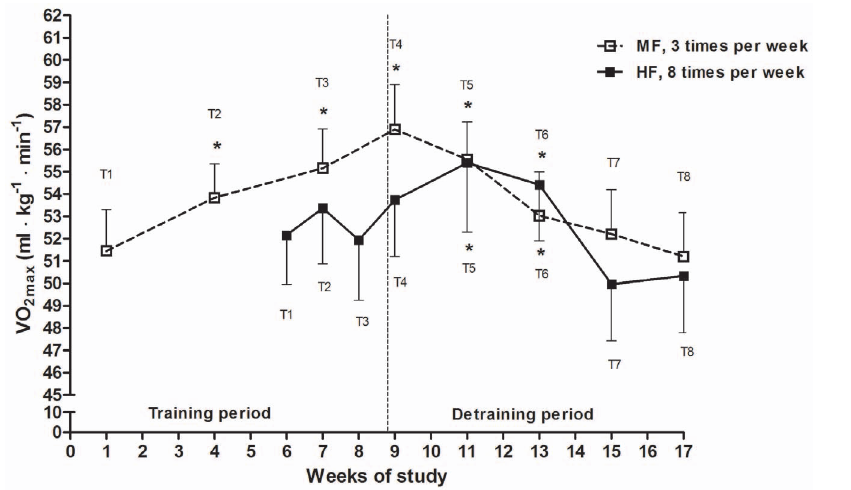
Figure 2. Mean values and standard error of the mean of VO 2max for the two groups during the training and the detraining period are shown. Vertical dotted line states the last day of training. Confer Table 2 for statistics and exact values at test points (T1–T8). * Indicates significant differences from baseline within groups.